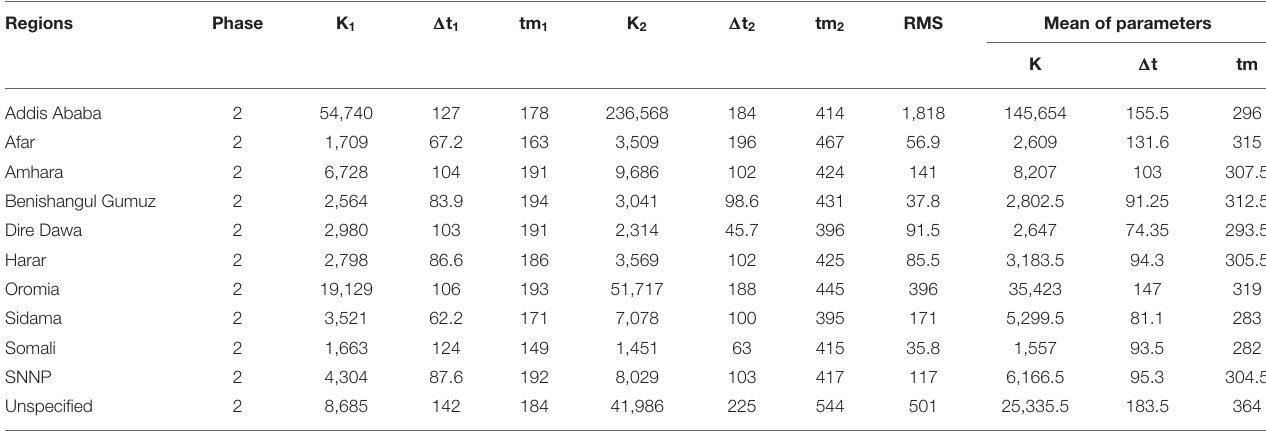
TABLE 2 | The fitted parameters for the bi-logistic approximation for the dynamics of the cumulative incidence in each region and city administration of Ethiopia. Regions